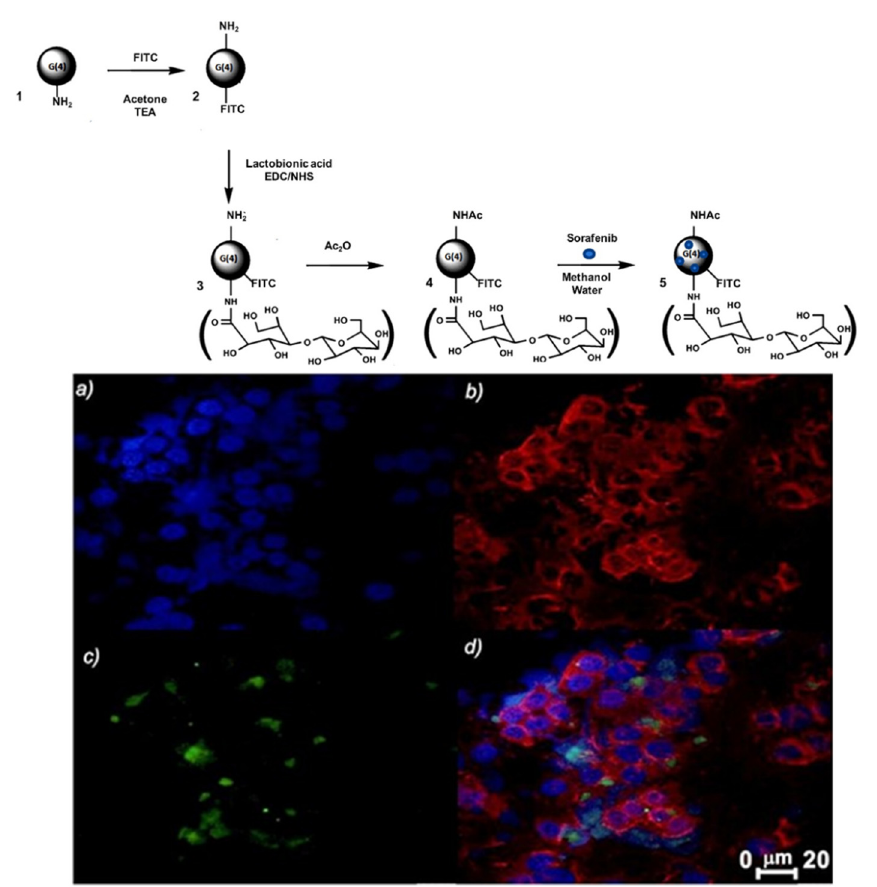
Figure 5. Upper panel shows the scheme of the synthesis of G(4)-PAMAM-FITC (2), Ac-La-G(4)- PAMAM-FITC (4), and Ac-La-G(4)-PAMAM-FITC/sorafenib (5) dendrimers; bottom panel shows representative single confocal slices of fixed HepG-2 cells: HepG-2 cells imaged with ( a ) DAPI; ( b ) Phalloidin-TRITC; ( c ) Ac-La-G(4)-PAMAM-FITC 4; ( d ) overlay after an incubation period of 15 min. Bar: 25 µ m. Adapted with permission [32]. Copyright 2017, Elsevier